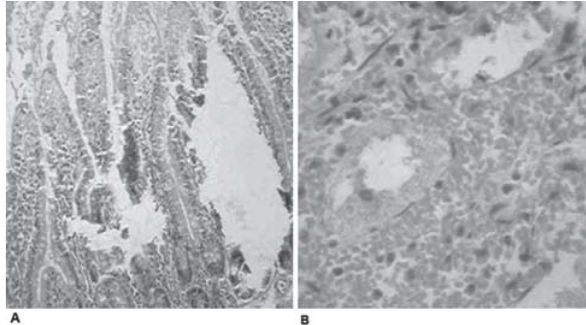
Fig. 6 - Fotomicrografia do grau 4 da classificação de Chiu et al. [6] (HE, A x 100, B x 400) - rato 8 do grupo A